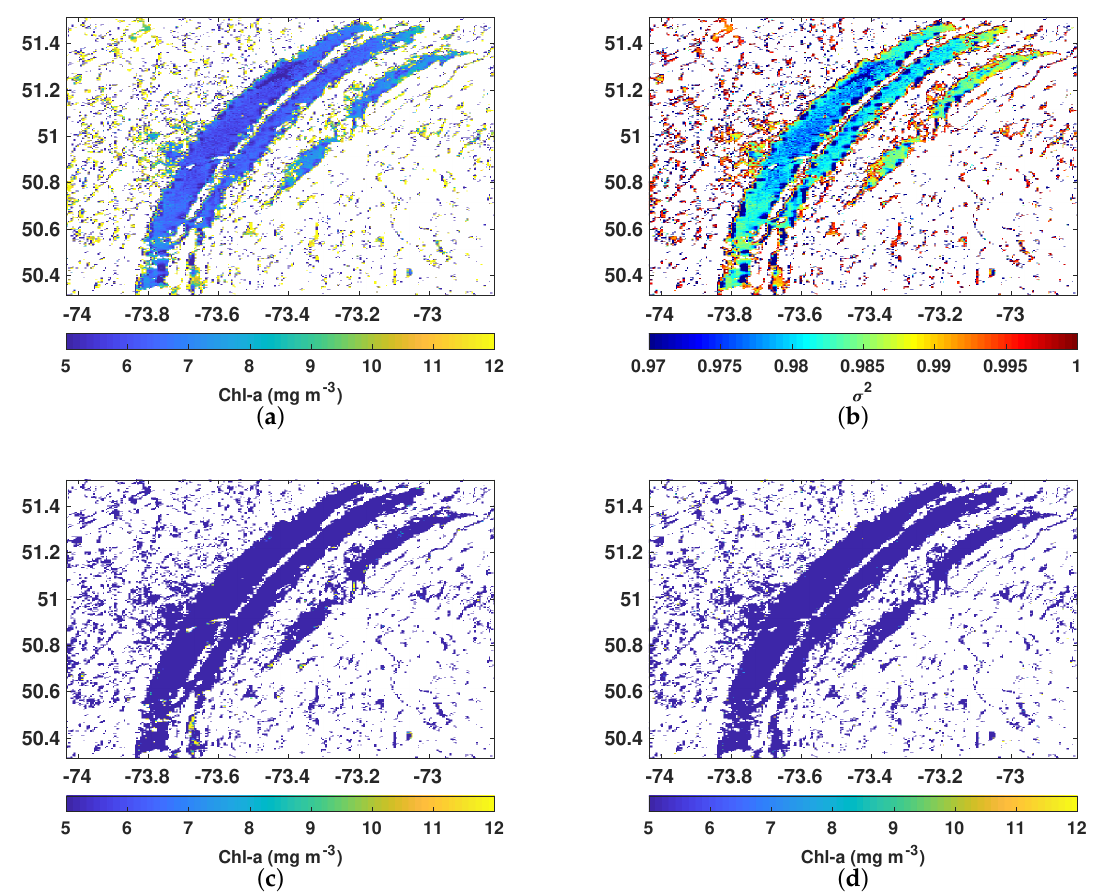
Figure 12. Region 3, Mistassini Lake: Estimated Chl-a concentration ( a ) and the corresponding certainty map ( b ). Chl-a concentration map by the NNs ( c ) and OC4 ( d ). The unit of Chl-a is mg m − 3 , and the certainty (variance) is